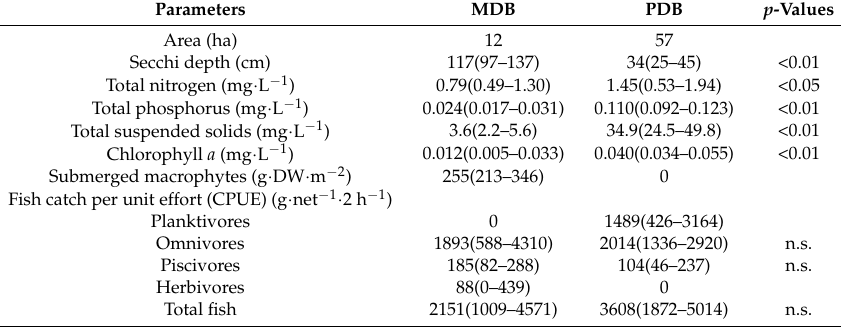
Table 1. Characteristics (mean, range, and p -values of Kruskal–Wallis tests) of the restored basin of Huizhou West Lake, MDB, which is clear, has low chlorophyll a and a submerged macrophyte cover of >80%, and an unrestored basin, PDB, which is phytoplankton dominated and has high levels of chlorophyll a and suspended matter. Data are from Gao et al.